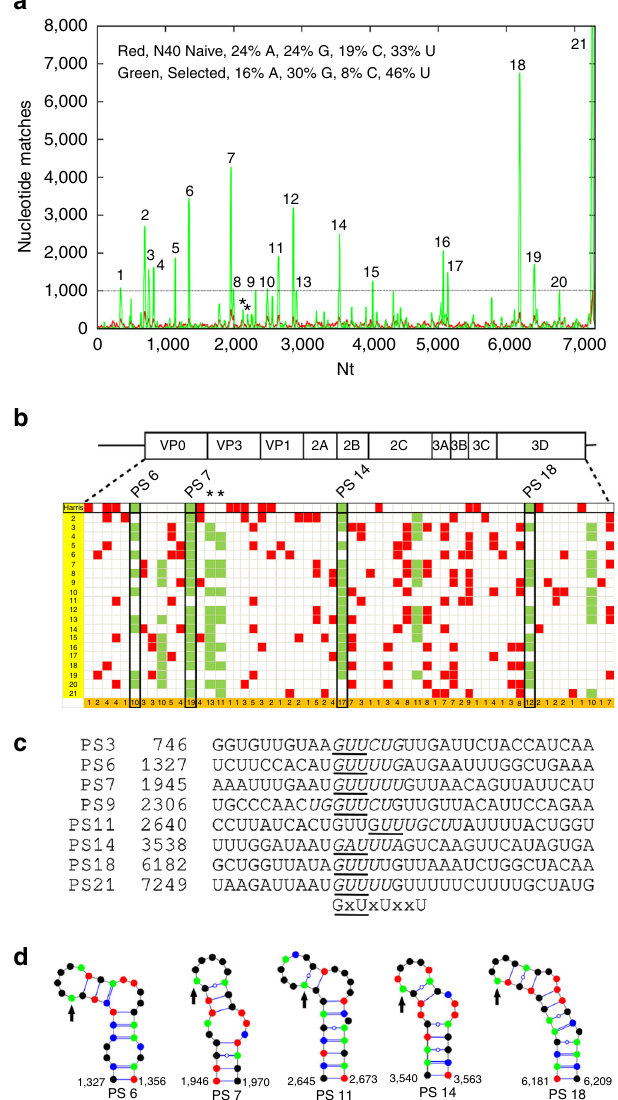
Fig. 2 Identi fi cation of putative PS positions within the HPeV1 Harris genome. a Histogram plot showing alignments of aptamer sequences with Bernoulli scores ≥ 12 to the HPeV1 genome for the enriched SELEX pool ( green ) and the N40 naïve library ( red ), base compositions of both pools shown inset . The dashed line , corresponding to the highest peak in the match of the naïve library to the Harris genome, indicates the initial threshold used to identify areas with statistically signi fi cant sequence similarities. b Alignment of the results of similar plots for the other 20 complete genome sequences of HPeV1 strain variants are shown with the data from the Harris strain (vertical axis, Harris strain = 1; see Supplementary Table 1 for the Genbank IDs). The positions of statistically signi fi cant peaks, i.e. peaks above the level of the highest background peak, within the coding regions of each genome are shown as fi lled cells in the Table. These were aligned within the polyprotein coding region using Clustal 19 . Peaks within the Harris strain are termed PSs and are aligned with equivalent sites in the other strains, provided the peak nucleotides lie within 10 nucleotides of the Harris PSs. The last row of the table shows the number of such matches from all the strains. Co-localised peaks in more than 47% of the strains are shown in green , the others are in red . The asterisks in a , b indicate two peaks, PS8A and PS8B, which are below the statistical cut-off de fi ned by the naïve library but are highly conserved in > 47% of the non-Harris strains. They have similar predicted secondary structures, suggesting that they are also PSs (Supplementary Fig. 2b). c Alignments of a subgroup of Harris PS secondary structures, some of which are shown as VARNA 39 representations in d with G — green ; C — blue ; A — red and U — black . Sequences that appear in the terminal loops of these structures are italicised in c while occurrences of the triplet GxU (see Fig. 3) are underlined. d Mfold structures for four PSs with the arrows indicating the start of the GxU motifs that occur at the 5 ′ end of the single-stranded loops (see Supplementary Fig.